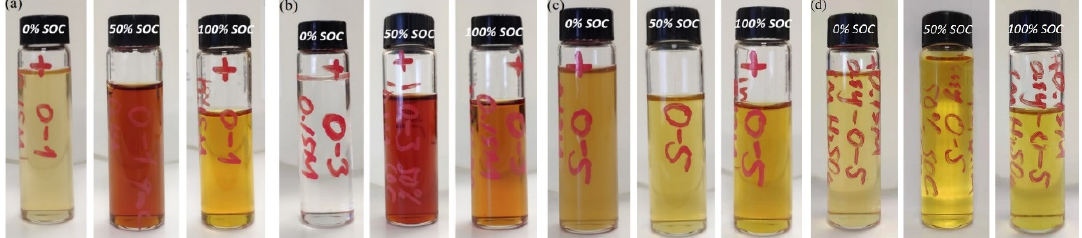
Figure 5. Colors of hydroquinone solutions at different SOCs, indicating the charge/discharge status of the flow cell. ( a ) 0.15 M O-1 in 1 M H 2 SO 4 at 0% (light yellow), 50% (red) and 100% (orange) SOC; ( b ) 0.15 M O-3 in 1 M H 3 PO 4 at 0% (colorless), 50% (red) and 100% (orange red) SOC; ( c ) 0.1 M O-5 in 1 M H 2 SO 4 at 0% (orange red), 50% (light yellow) and 100% (bright yellow) SOC; ( d ) 0.15 M asym-O-5 in 1 M H 2 SO 4 at 0% (light yellow), 50% (yellow) and 100% (bright yellow) SOC.